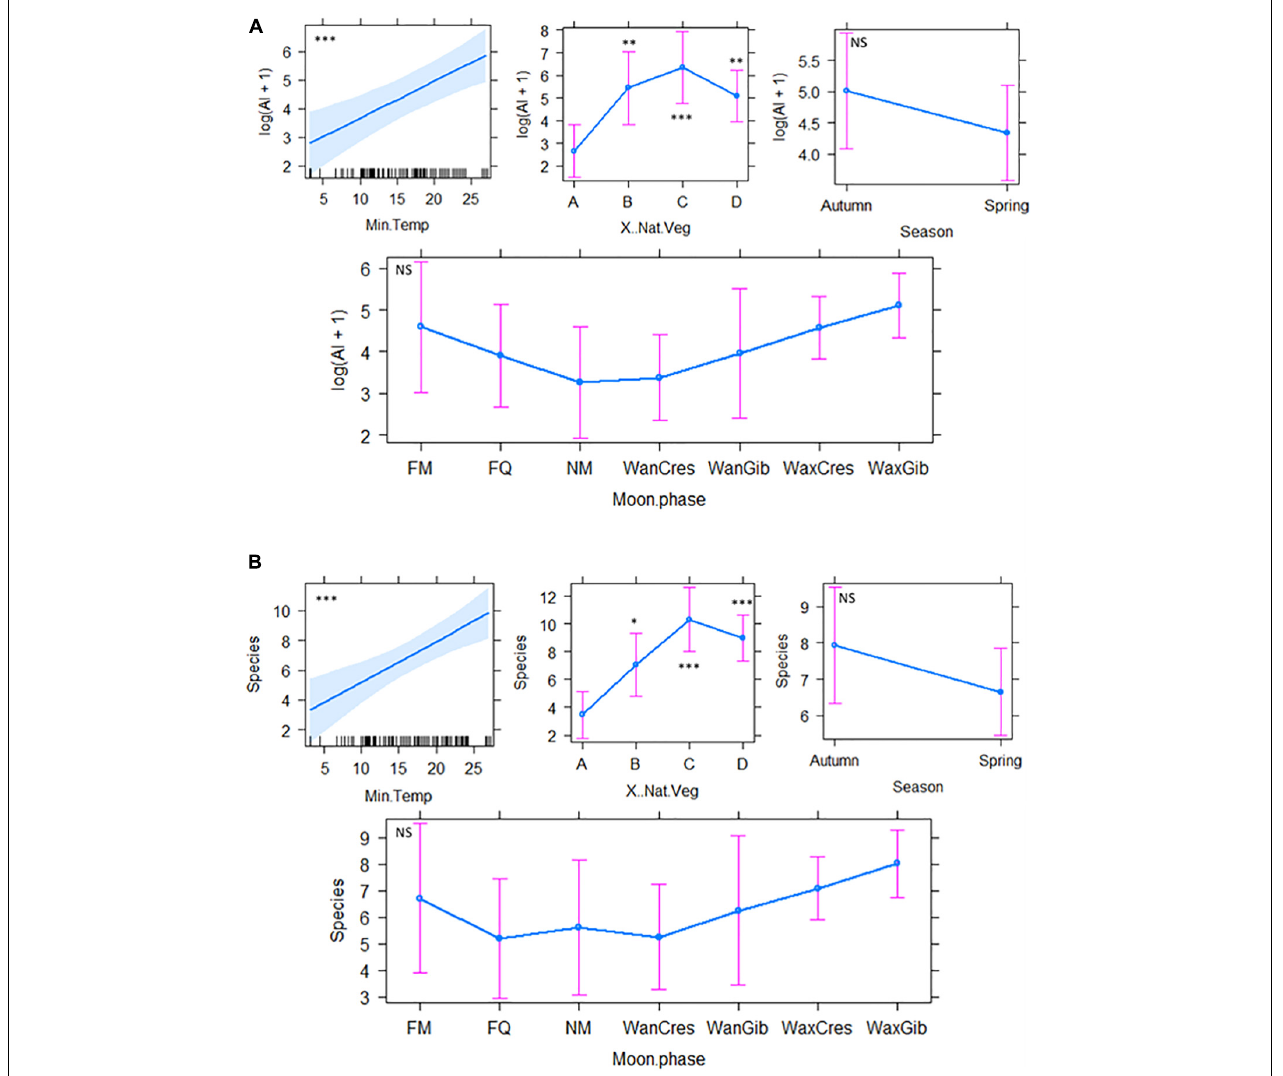
FIGURE 3 | The best fit model outputs for (A) AI (model #2) and (B) species (model #1) showing the influence of season, maximum luminosity, noise (dB), percentage of natural vegetation cover and moon phase on bat richness and activity. Bat detector and date were set as the random factors. Codes in